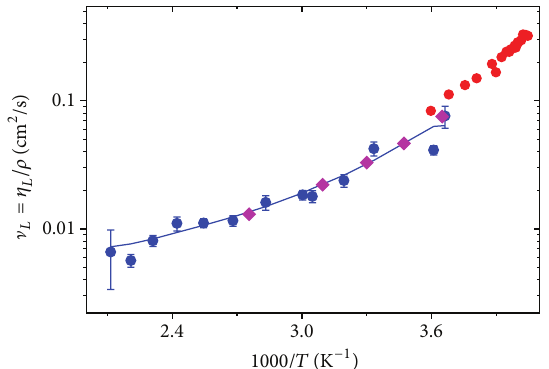
Figure 16: The Arrhenius plot of longitudinal viscosity of water as determined by (i) 𝑄 = 0 extrapolation IXS results from [13] (blue dots); (ii)shear viscosity data multiplied by a factor 4 from [38] (blue line); (iii) BLS data in the supercooled region [7] (red circles); and (iv) US measurements [39] (purple